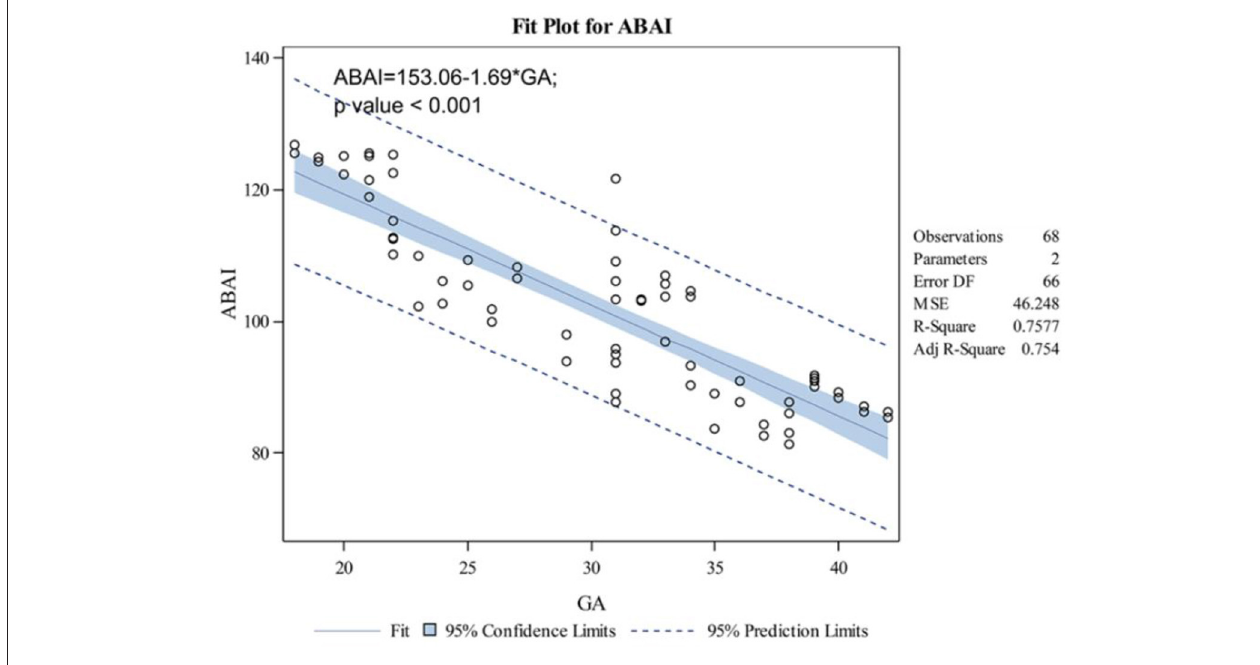
FIGURE 6 | Correlation between gestational age and anterior bony acetabular index.